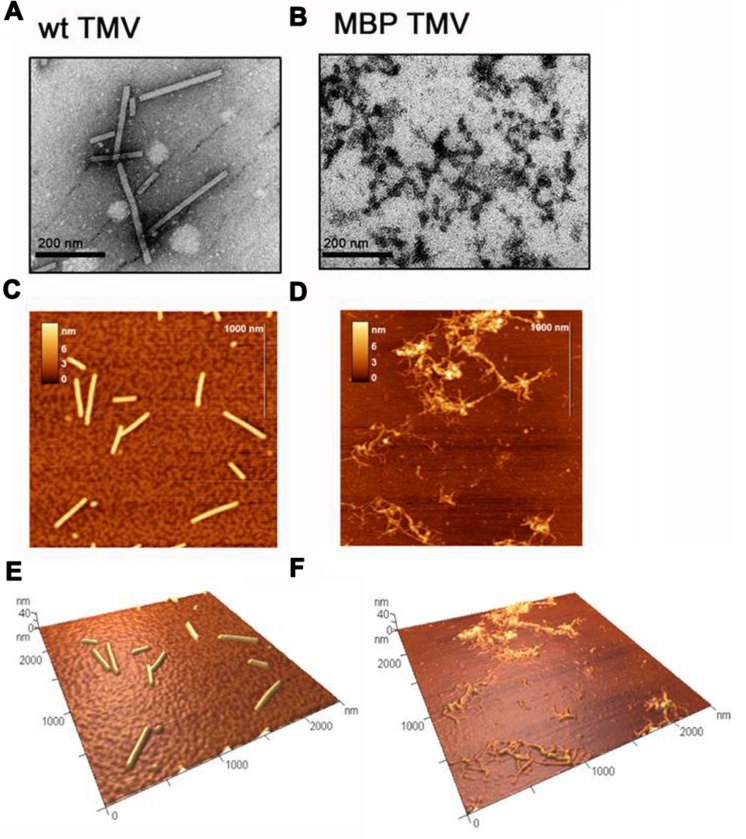
Transmission electron microscope (TEM) images of (A) wild type (WT) tobacco mosaic virus (TMV) and (B) MBP TMV, with scale bars shown. Atomic force microscopy (AFM) images with scale bars of (C) WT TMV and (D) MBP TMV, and their respective 3D projections (E) and (F).